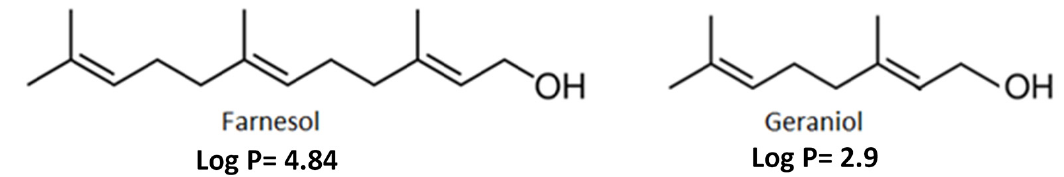
Figure 1. Chemical structure of farnesol and geraniol.